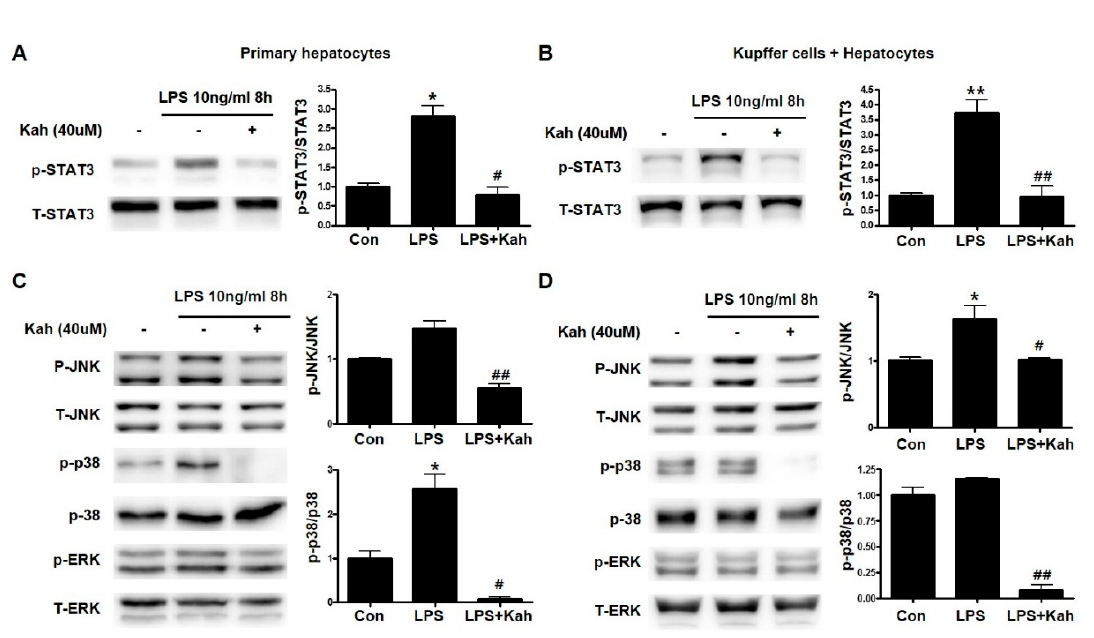
Figure 5. Effect of kahweol on lipopolysaccharide (LPS)-induced activation of the STAT3 and MAPK signaling pathways. ( A , B ) Primary hepatocytes ( A ) and co-culture of primary Kupffer cells with hepatocytes ( B ) were pretreated with kahweol (Kah) and then stimulated with or without LPS. The expression of phospho (p)-STAT3 was analyzed by western blot. Data represented in the bar graph are the mean ± SEM of three independent measurements. * p < 0.05, ** p < 0.01 compared with control (Con), # p < 0.05, ## p < 0.01 compared with LPS. T-STAT3, total STAT3 ( C , D ) Primary hepatocytes ( C ) and co-culture of primary Kupffer cells with hepatocytes ( D ) were pretreated with kahweol and then stimulated with or without LPS. The expression of p-JNK, p-p38, and p-ERK were analyzed by western blot. Data represented in the bar graph are the mean ± SEM of three independent measurements. * p < 0.05 compared with control (Con), # p < 0.05, ## p < 0.01 compared with LPS. T- JNK, total JNK. T-ERK, total ERK.